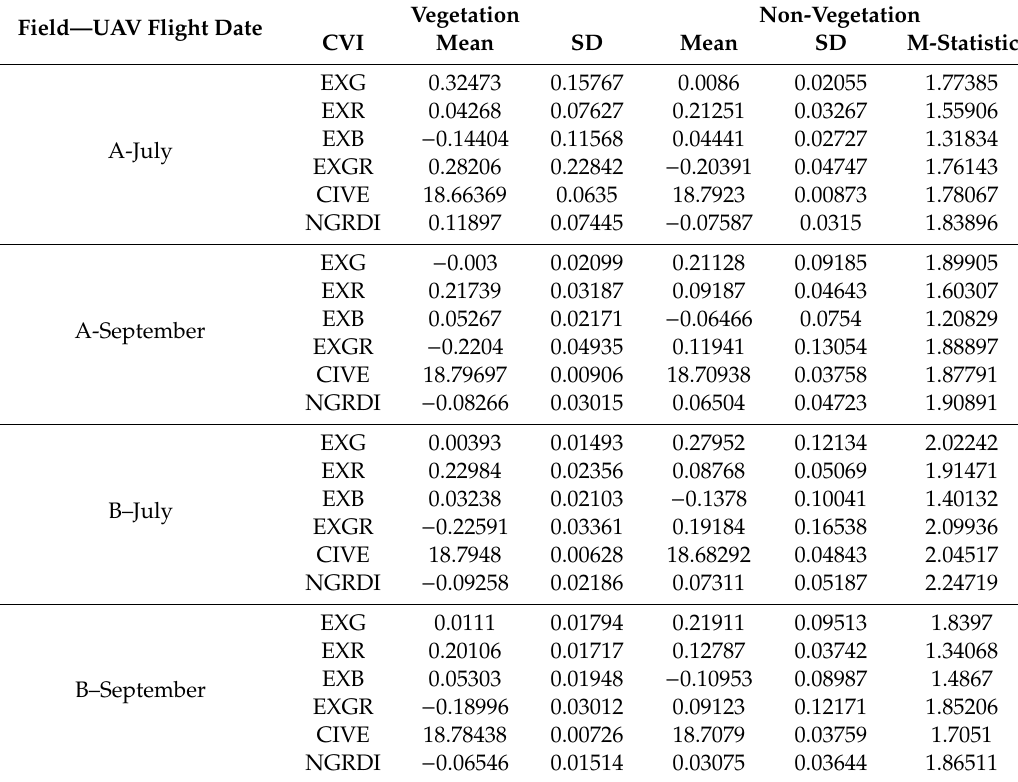
Table 3. Mean and standard deviation (SD) of each color vegetation index (CVI) per field and UAV flight date for the vegetation and non-vegetation classes and result of the M-statistic